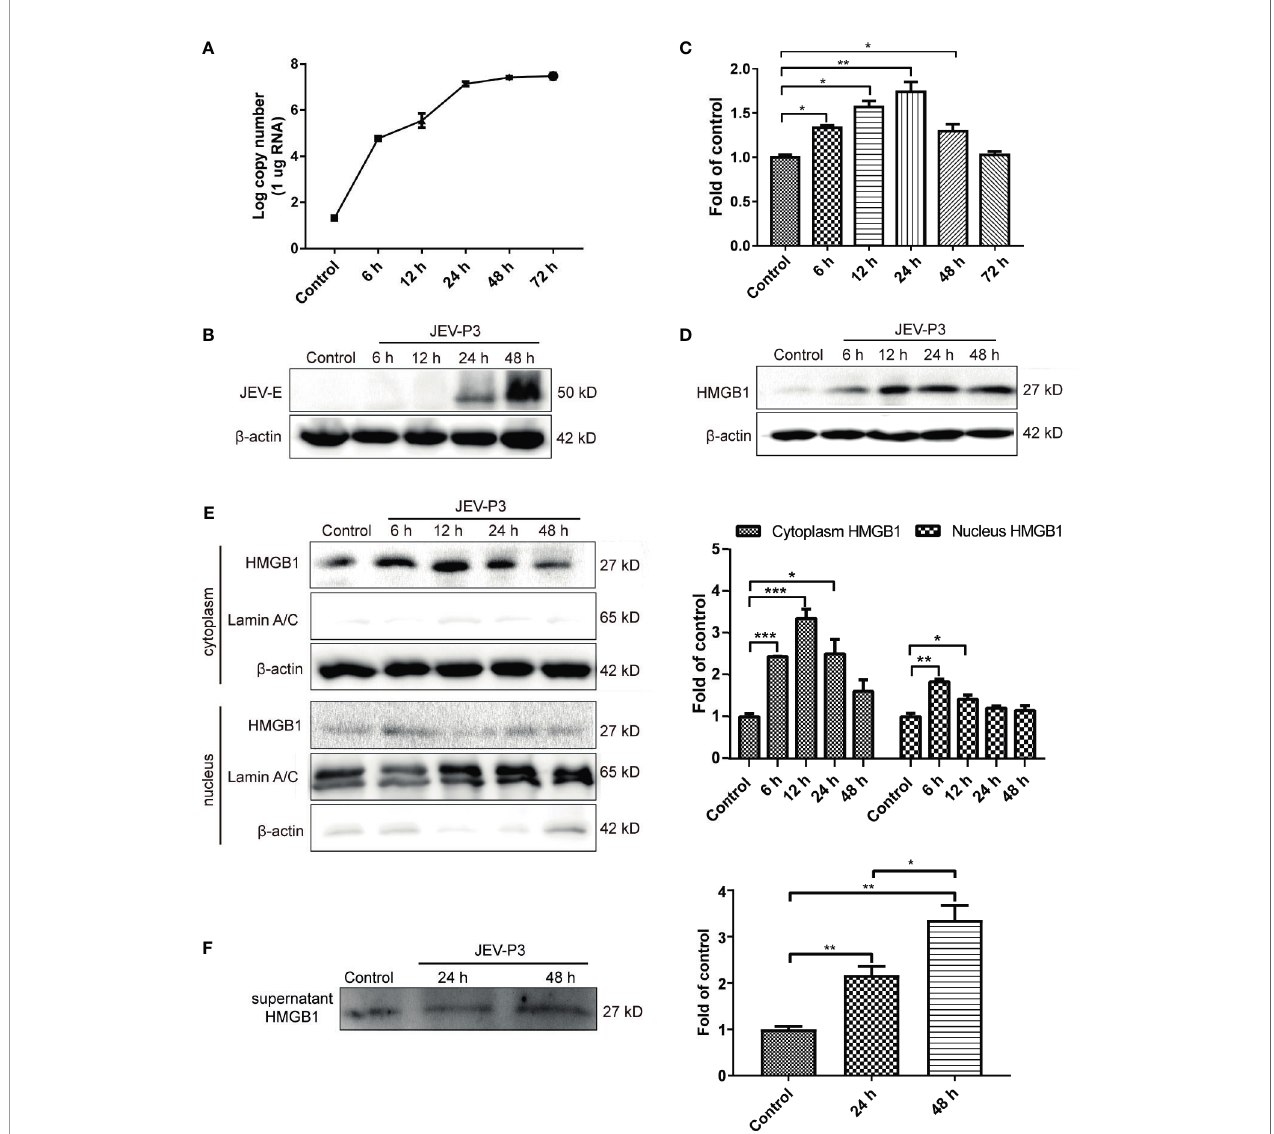
FIGURE 1 | JEV-induced fl uctuation of HMGB1 in HBMECs. HBMECs were infected with JEV-P3 at an MOI of 1, and total cell protein and RNA samples were collected at the indicated times to measure JEV replication in HBMECs by real-time PCR (A) and Western blotting using an anti-JEV-E protein monoclonal antibody (B) . HMGB1 expression was measured by real-time PCR (C) and Western blot (D) at the indicated times during JEV infection. JEV free cells were served as control. (E) Total cytoplasmic and nuclear proteins were extracted from JEV-infected HBMECs at 0 h (Control), 6 h, 12 h, 24 h, and 48 h postinfection. HMGB1 protein expression was measured by Western blotting, with beta-actin as the internal control for protein integrity and Lamin A/C was assessed in the nuclear extract, and quantitatively analyzed as the fold change relative to the control. (F) HBMEC culture supernatant was collected at indicated times after virus infection (24 h, and 48 h). Supernatant HMGB1 was measured by Western blotting and quantitatively analyzed as the fold change relative to the control (JEV-free cell culture supernatant). The experiments are repeated at least three times. The data are expressed as the means ± SEM. * p < 0.05, ** p < 0.01, and *** p <